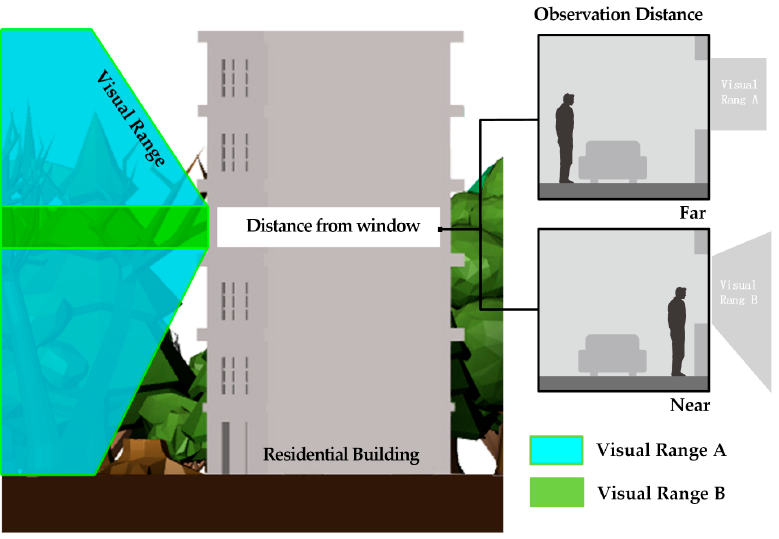
Figure 7. The visual scale between the two observation models.